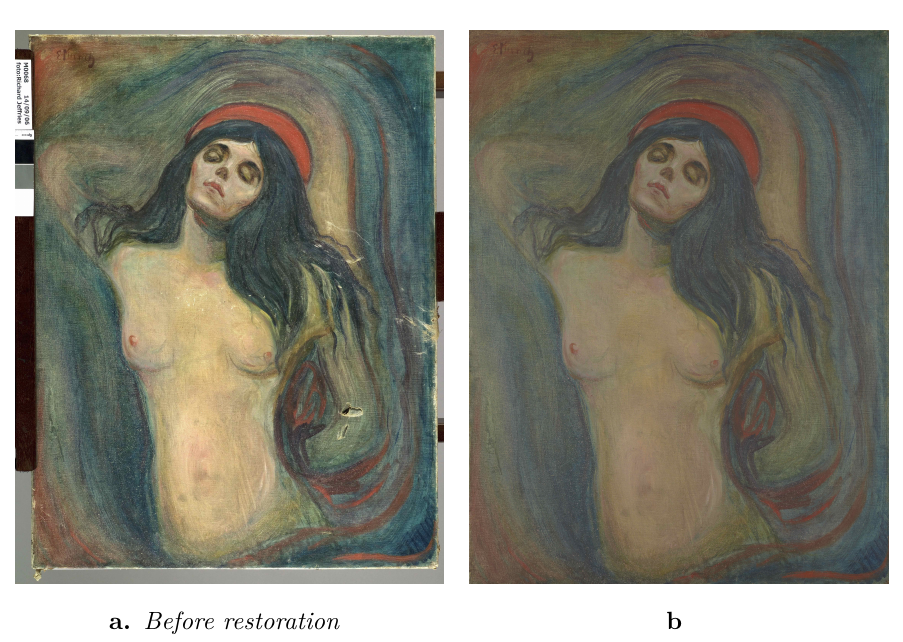
Figure 10: Madonna (1894) ©